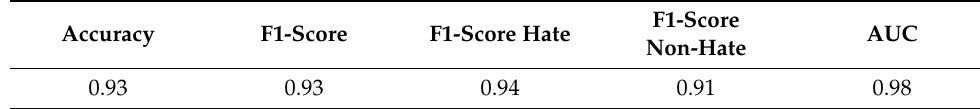
Table 2. Performance of the hate speech classification